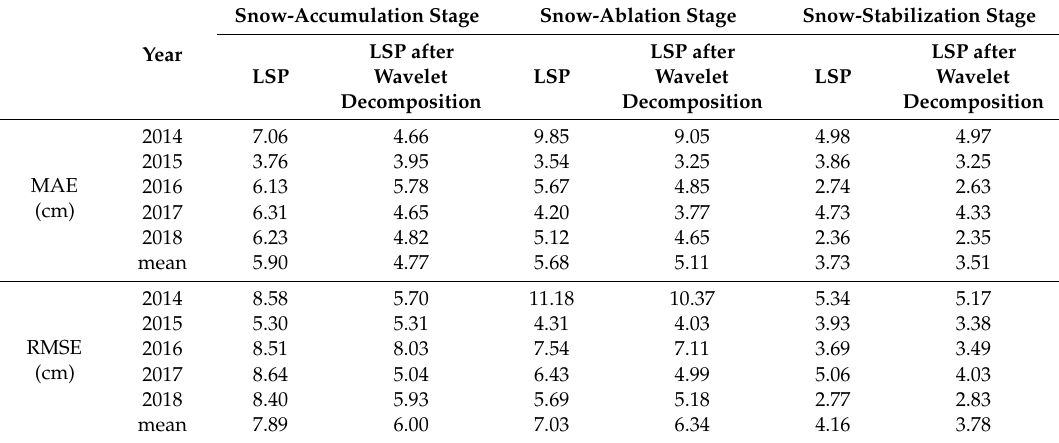
Table 3. Statistical results for estimated snow depths with respect to in-situ snow depths in situations of di ff erent snow-surface characteristics.